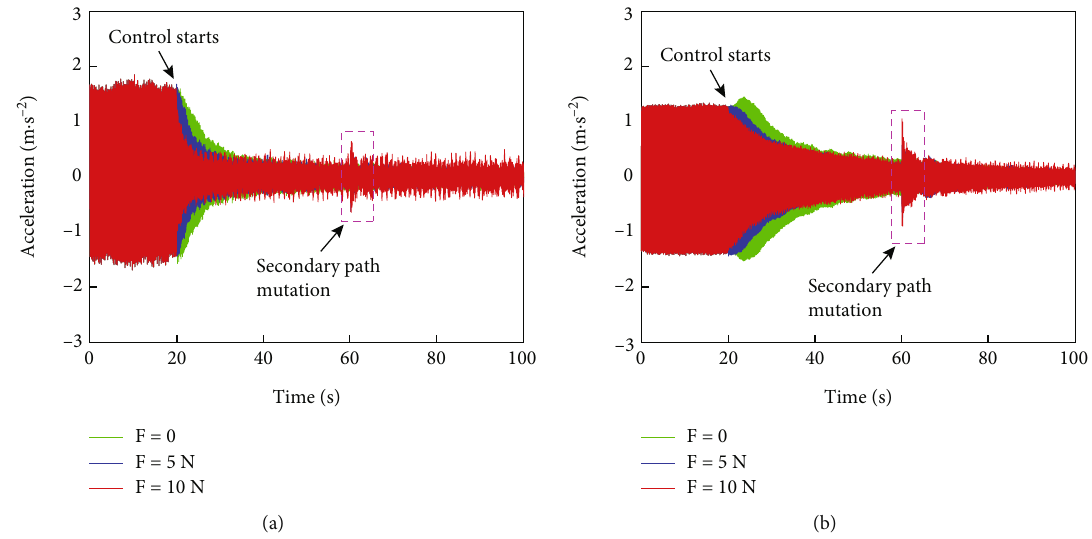
Figure 12: Acceleration response with multichannel LMS. (a) 1# point. (b) 2#